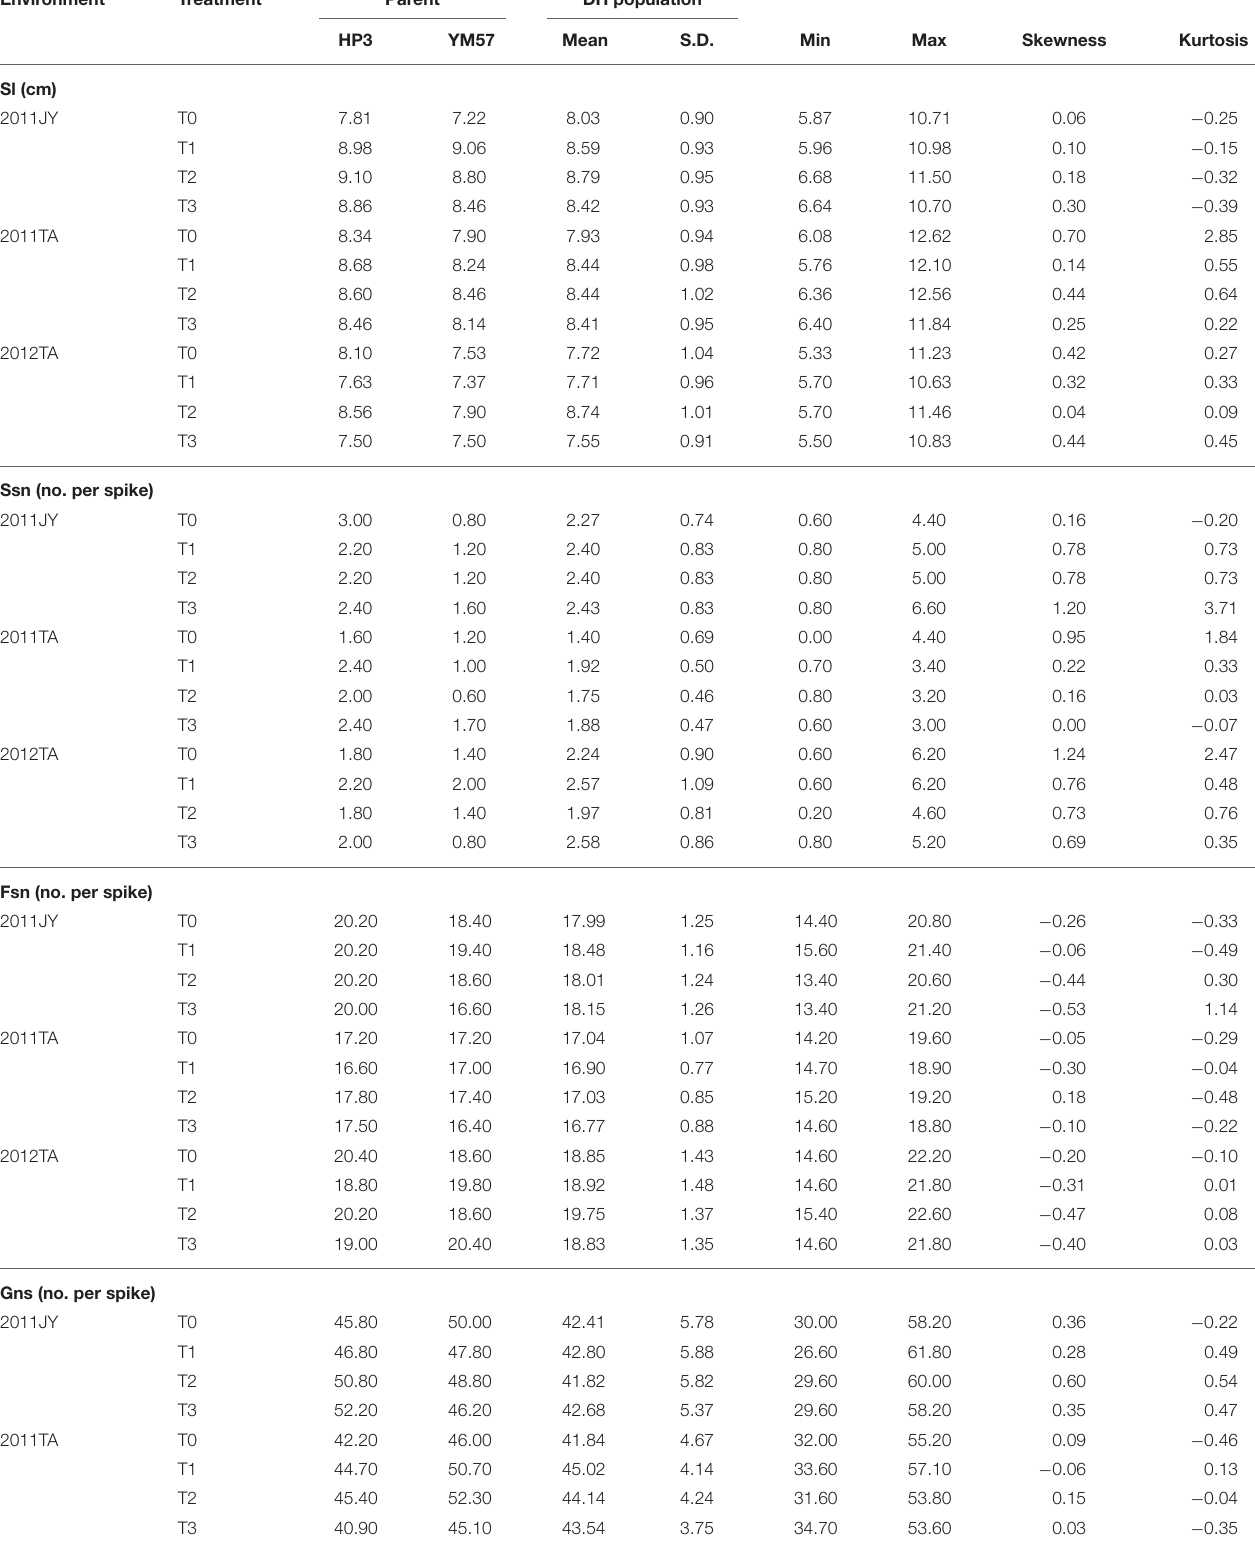
TABLE 1 | Distributions of five spike-related traits in parents and DH populations of wheat under different nitrogen supplying dates. Environment